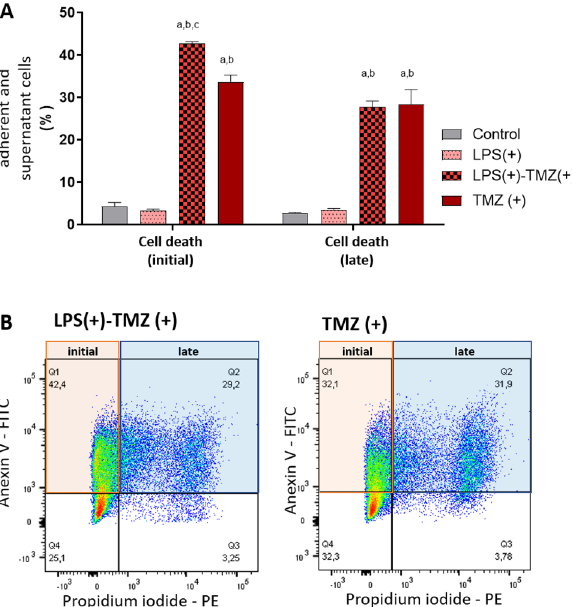
Figure 4. Cell death functional assay by flow cytometry. ( A ) U87MG cells were treated for 48 h with LPS, TMZ, and LPS together with TMZ. The cells were incubated with annexin V and propidium iodide (PI) and evaluated by flow cytometry for the adherent and supernatant cells. Statistical analysis was performed using a Two-way Anova p < 0.001 followed by Bonferroni post-test, where significance was a p < 0.001 compared to non-treated cells (control group), b p < 0.001 compared to cells treated with LPS, and c p < 0.001 in comparison to cells treated with TMZ. ( B ) Representative scatter plots of Annexin V-FITC/PI staining of U87MG cells with TMZ alone or in combination with LPS. The initial cell death phenotype was indicated when the cells were positive by annexin V (orange). Late cell death was given by the positivity for annexin V and PI (blue).